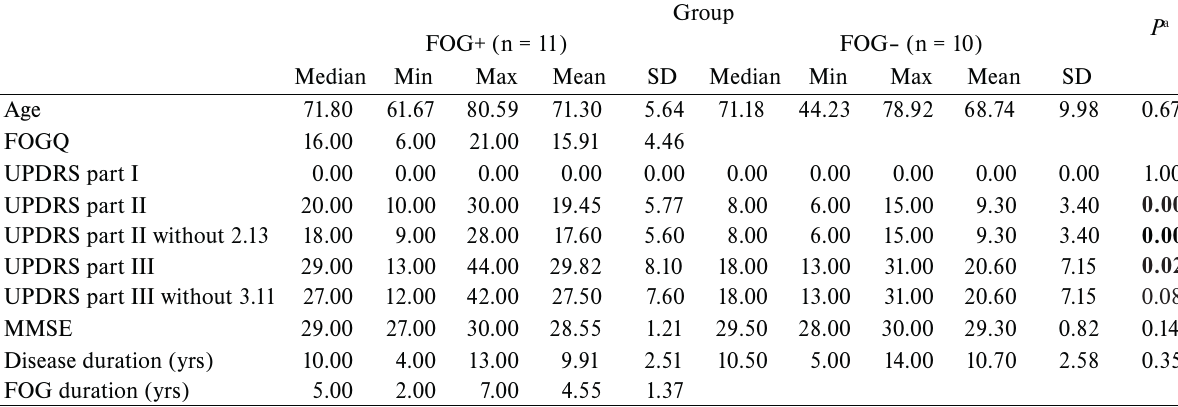
Table 1. Clinical group characteristics – numeric variables.